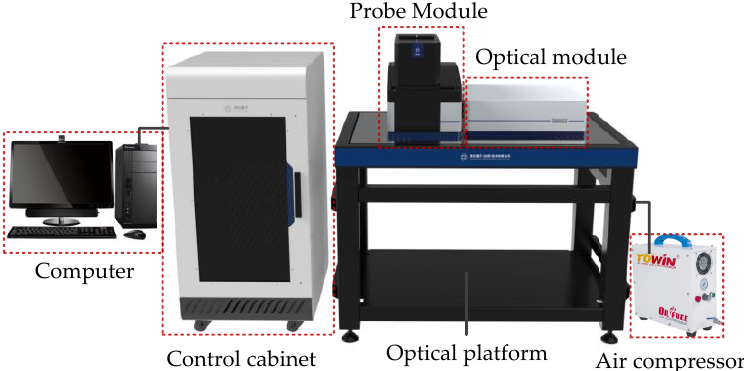
Figure 18. Quantum diamond single-spin spectrometer system.